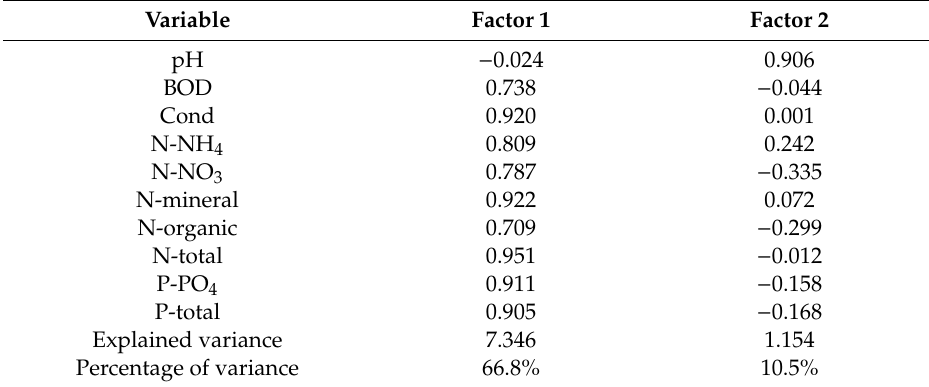
Table 3. Principal component analysis of the chemical variables. Varimax normalized